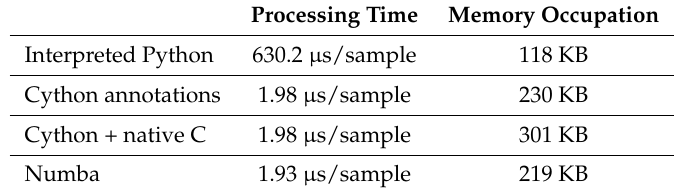
Table 1. Diode ring modulator: mean processing time and memory occupation of different implementations; chunk_size = 512; processing time averaged over 1000 chunks. (Real-time limit: 22.6 µ